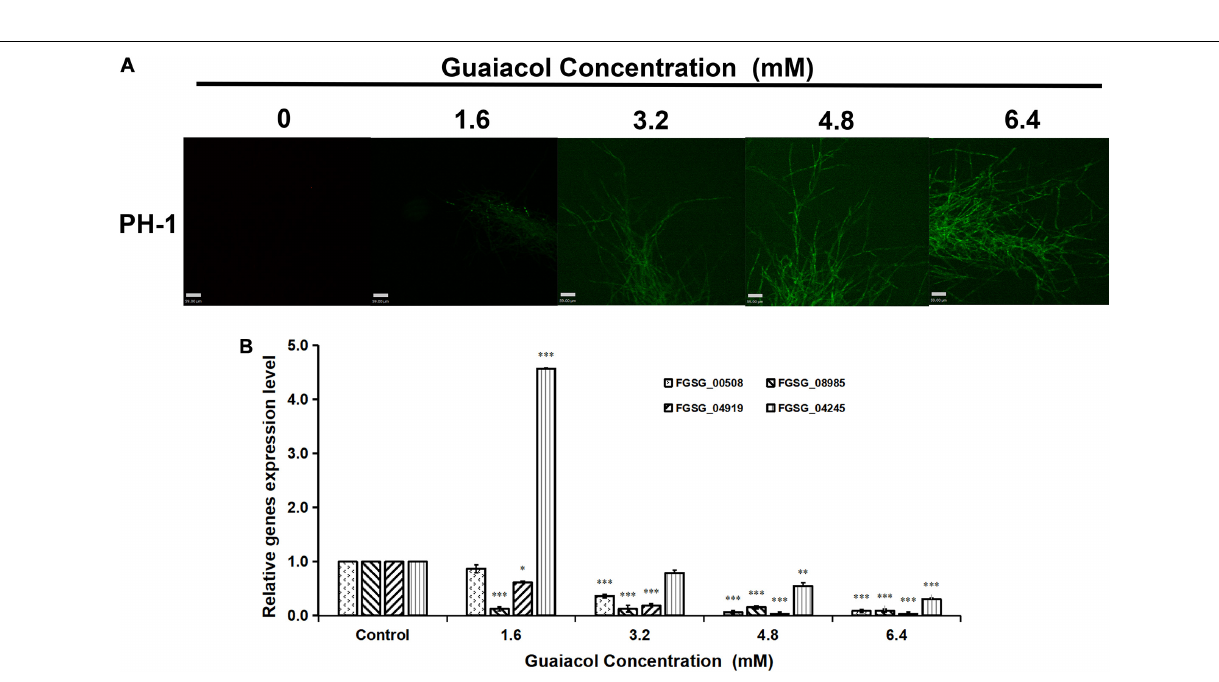
Frontiers in Microbiology |